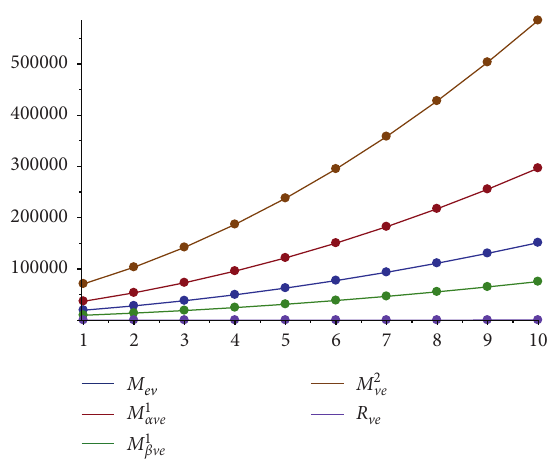
Figure 2: The graphical representation of M